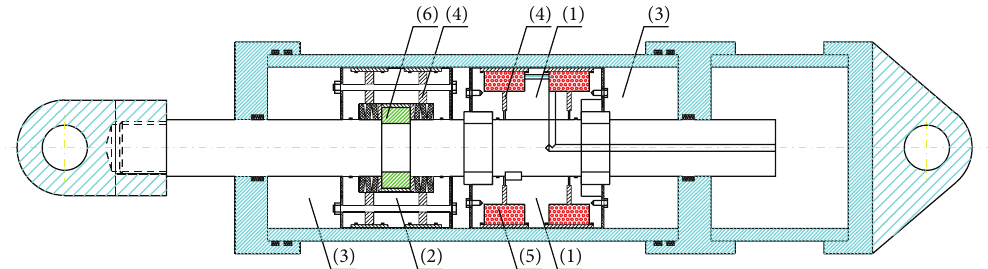
Figure 1: Structure of the SDMR